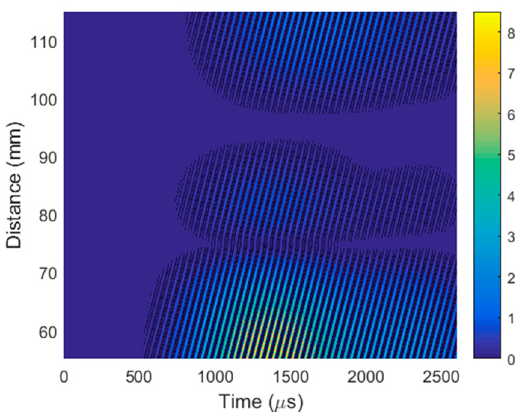
Figure 22. B-scan obtained using virtual air-coupled receiving phased array before filtering.